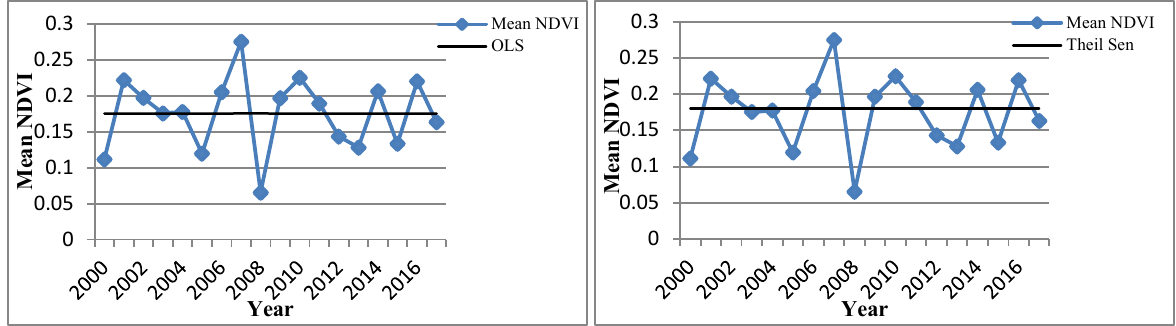
Figure 2. Vegetation dynamics in 16-day NDVI composite for spring season during 2000-2017